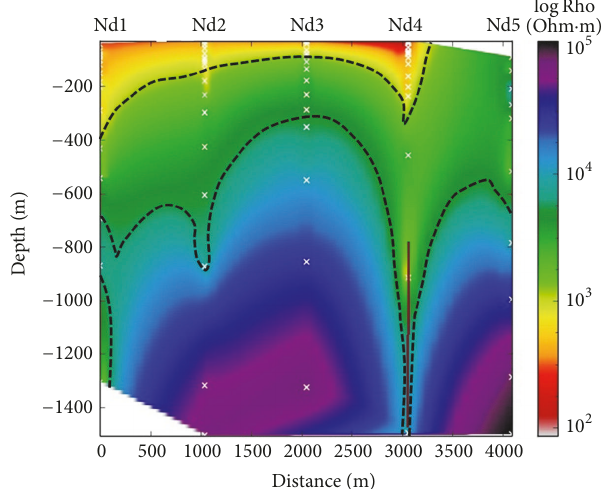
Figure 13: Geoelectrical section of Ndokayo profile at 1500 meters’ depth.